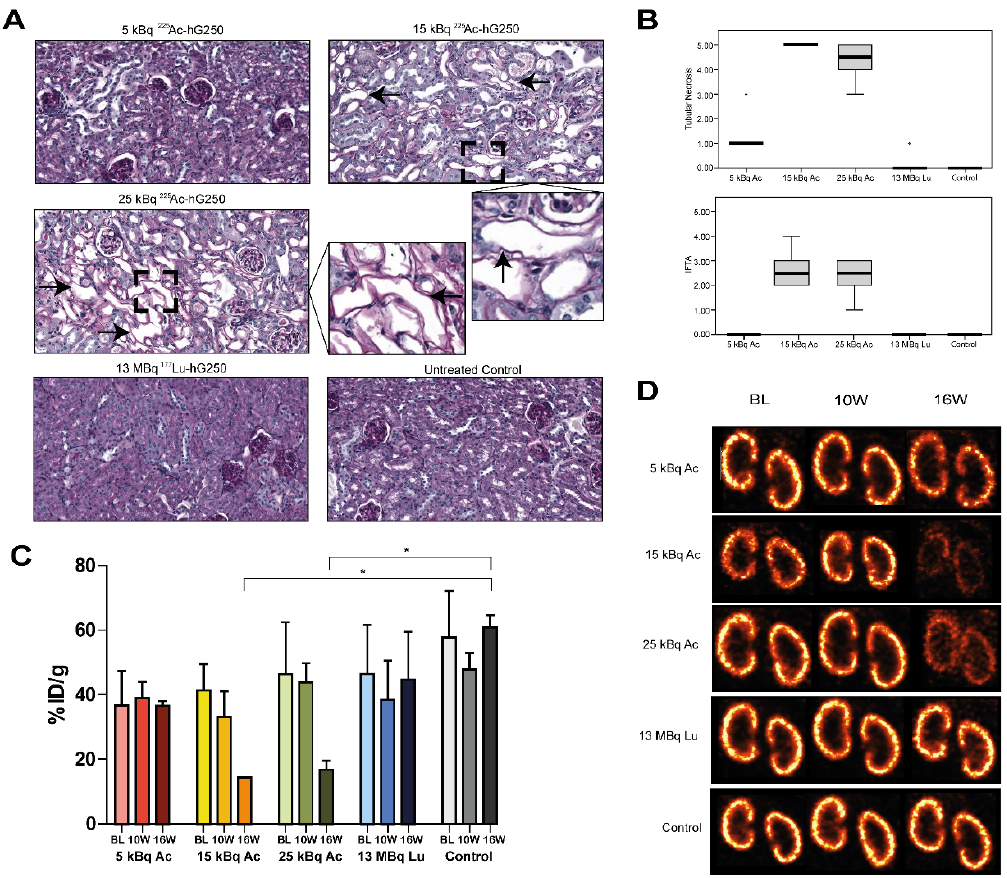
Figure 6. ( A ) Representative kidney slices stained with periodic acid-Schiff from non-tumor bearing mice either untreated or treated with different activity doses of 225 Ac-hG250 or 177 Lu-hG250, 18 weeks post-treatment. Arrows indicate tubular denudation. ( B ) Scoring of IFTA and tubular necrosis of the kidneys in treated mice. ( C ) Quantative uptake of 99m Tc-DMSA in kidneys of treated mice, expressed as %IA/g. * = p < 0.05). ( D ) Visualization of 99m Tc-DMSA SPECT imaging in treated mice. IFTA = interstitial fibrosis and tubular atrophy.